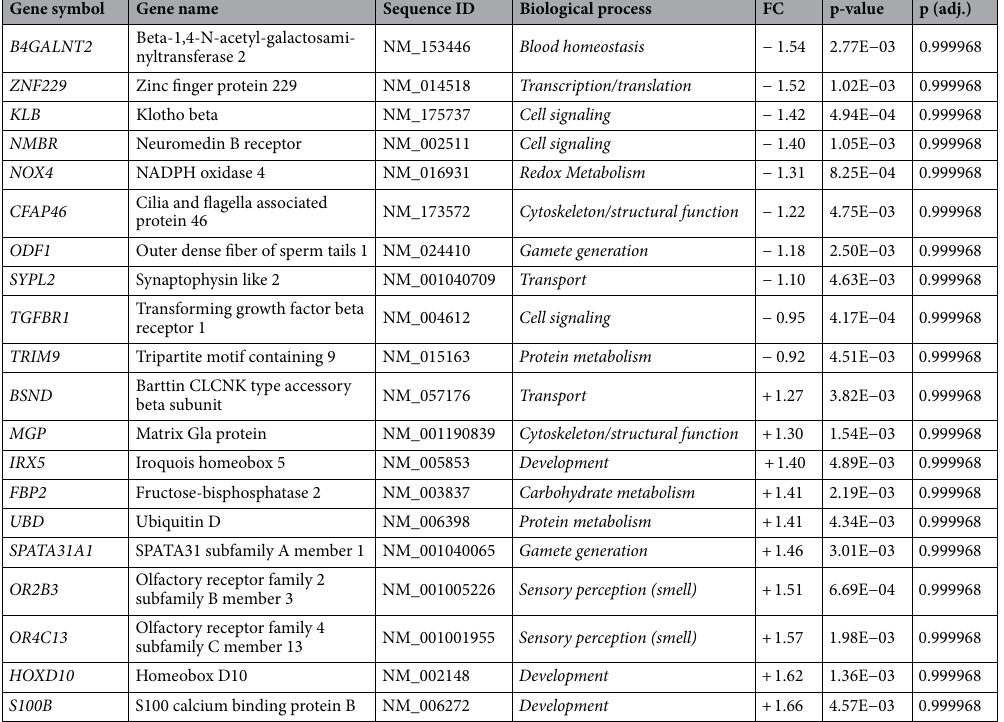
Table 3. Top 10 down- and up-regulated most significant (p < 0.005) genes by physical activity level in PBC ranked by Fold Change (FC, log2) indicating up-regulation (+) and down-regulation (−) by low physical activity, the Limma’s p-value and FDR adjusted p-value. Genes are ranked by